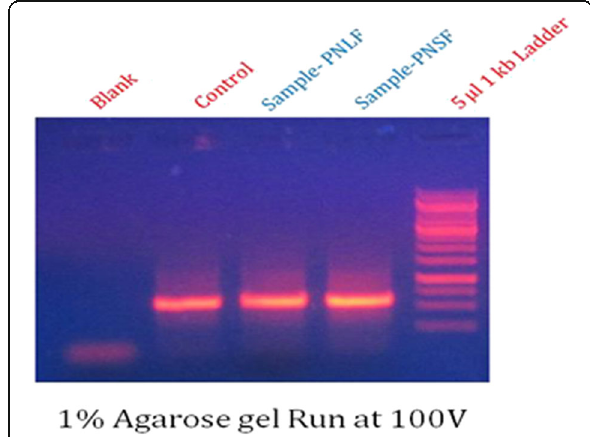
Fig. 2 Genomic DNA isolation and PCR amplification of the 16sr RNA